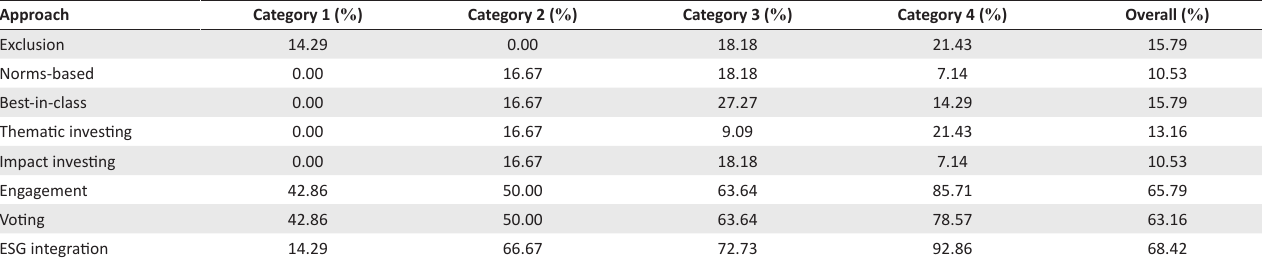
TABLE 4: Approaches to environmental, social and governance investing.